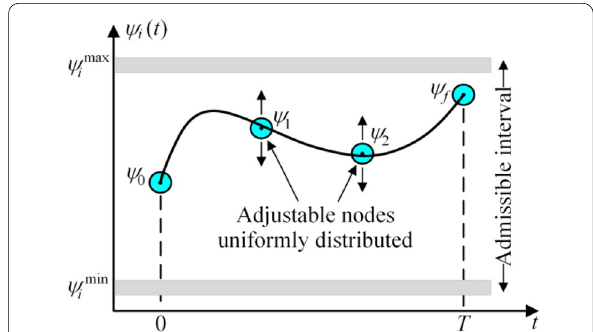
Figure 5 Composite polynomial curve of joint output angle temporal